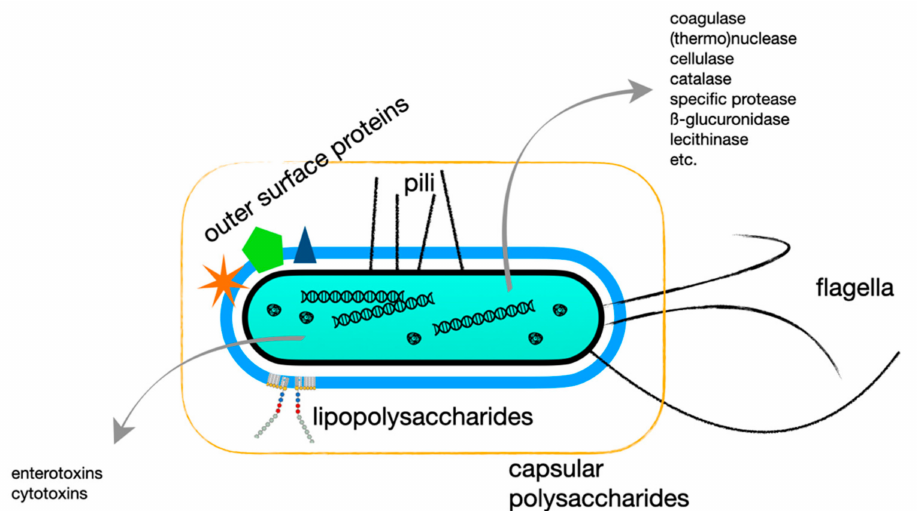
Figure 3. A simplified overview of “handles” of a Gram-negative bacterium analytically available to find a bacterial cell among all other food components. Flagella, H-antigen, are only present on motile cells and when present, it can be a single flagellum or multiple flagella organized mono-/lopho-/amphi-/peritrichously [57]. Lipopolysaccharides, O-antigens, form the outside of the outer membrane of the bacterial cell. Pili or fimbriae, F-antigens, are of little relevance to food microbiologists. Capsular polysaccharides (CPS), K-antigen, can be formed in both Gram-negative and Gram-positive bacteria. A special subtype of the K-antigen is the Vi-antigen in Salmonella. The activity of excreted enzymes is partly specific and used as a marker to identify a bacterium. Analysis of excreted toxins can also be used to trace and identify a pathogenic bacterial cell. The depicted lists of enzymes and toxins are not